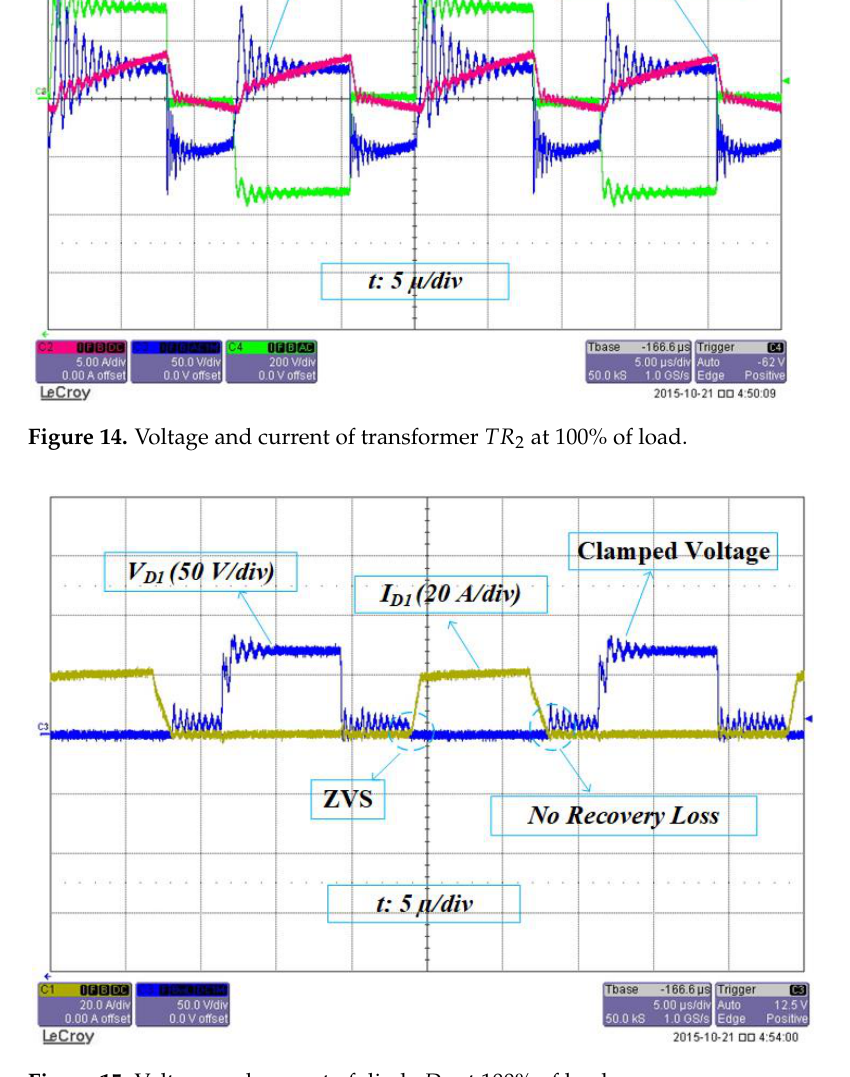
Figure 15. Voltage and current of diode 𝐷 1 at 100% of load.